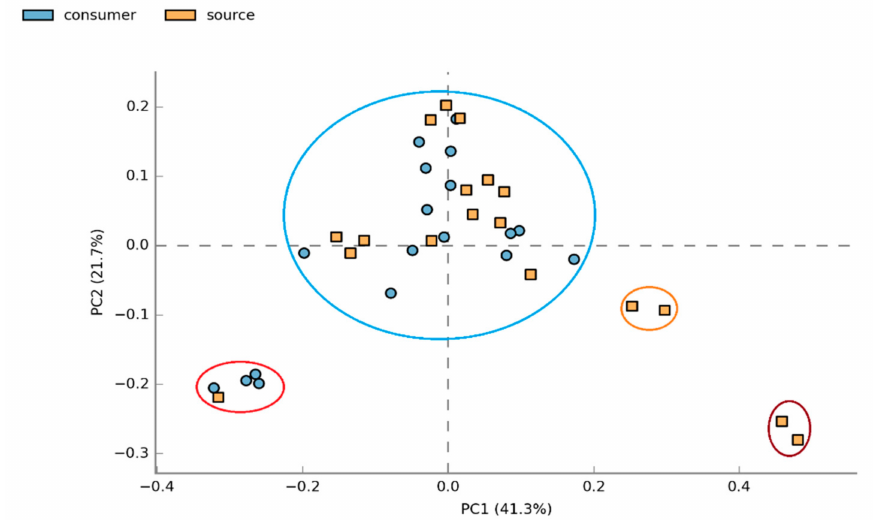
Figure 2. Principal coordinate analysis (PCoA) plot of bacterial communities in DWDS based on Bray–Curtis dissimilarity.